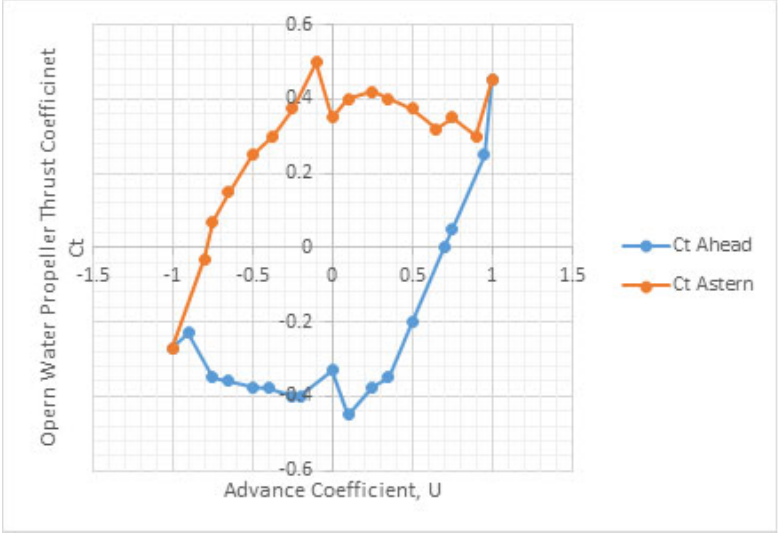
Figure 11. Shaft thrust coefficient vs. advance coefficient.